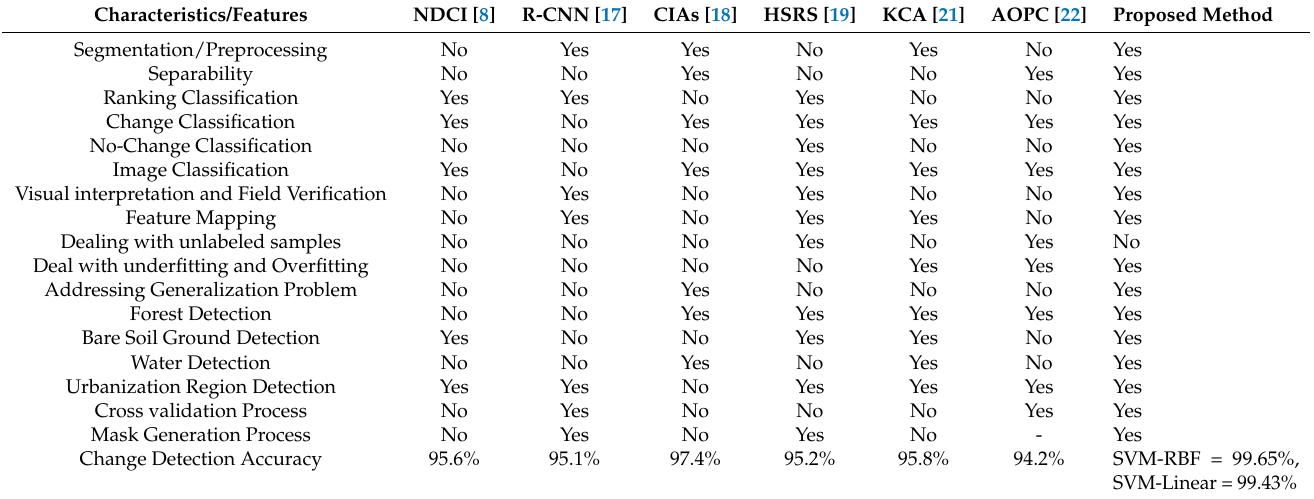
Table 1. Showing characteristics/ Features of contending algorithms for the land cover and land use. Characteristics/Features